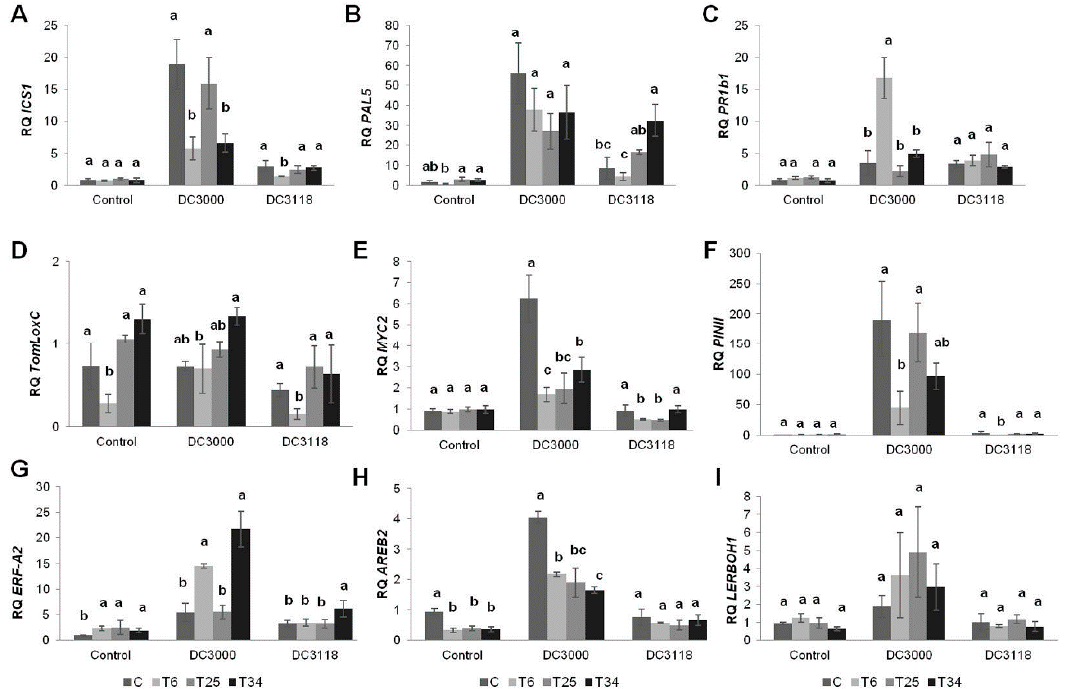
Figure 3. Relative expression of defense-response genes in 4-week-old tomato plants dip-inoculated with P. syringae strains (DC3000 and DC3118) or without Pst (Control) and treated with Trichoderma strains (T6, T25, and T34). Samples were collected at 72 hpi of Pst strains. Four biological replicates per treatment with three technical replicates each were used in the analysis. The data are displayed as the relative quantity (RQ, 2 − ∆∆ Ct ) + standard deviations of target genes compared to those of their basal condition (Mock (C), control plants untreated neither with Trichoderma nor with Pst ). The expression values of each gene were normalized to the quantity of actin gene used as the endogenous gene. The values in each bar followed by the same letter do not di ff er significantly (Tukey’s test at p < 0.05), for Control-, DC3000-, and DC3118-treated plants, respectively. Panels A–I correspond to the relative expression of genes: ICS1 ( A ), PAL5 ( B ), PR1b1 ( C ), TomLoxC ( D ), MYC2 ( E ), PINII ( F ), ERF-A2 ( G ), AREB2 ( H ), and LERBOH1 ( I ).